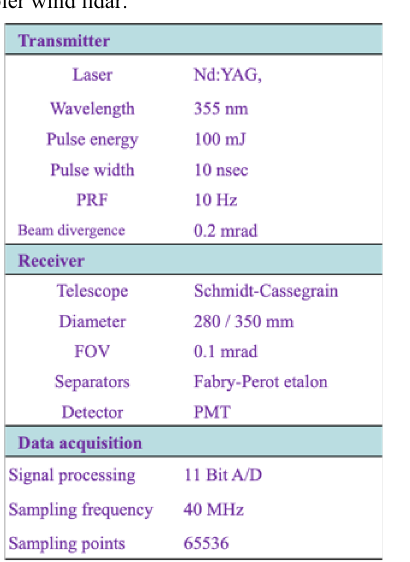
Table 1. Specifications of 355-nm direct-detection Doppler wind lidar.